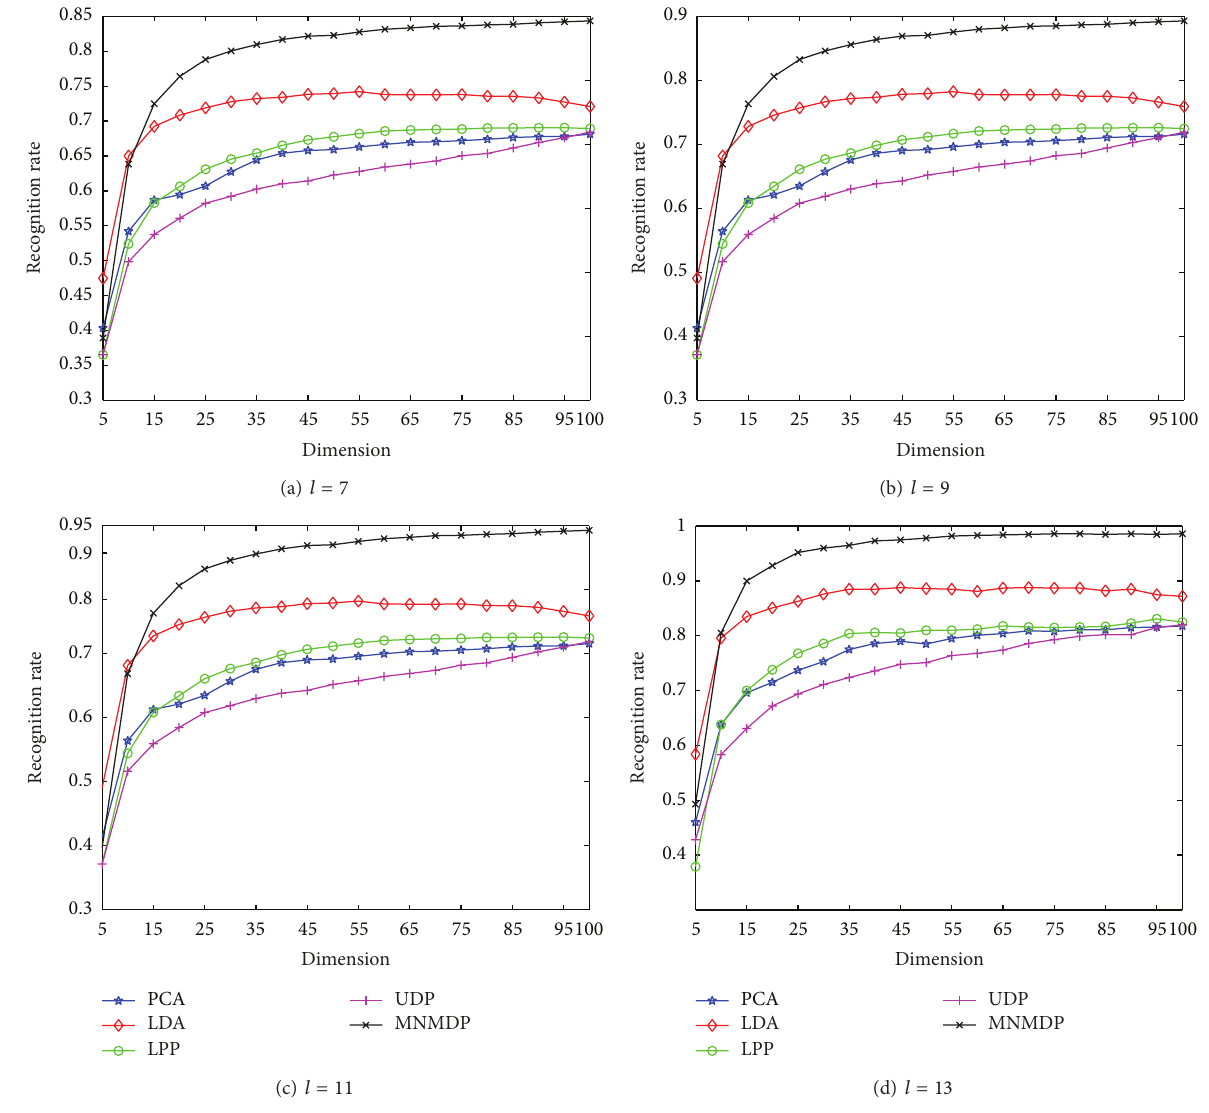
Figure 9: The average recognition rates versus dimension on